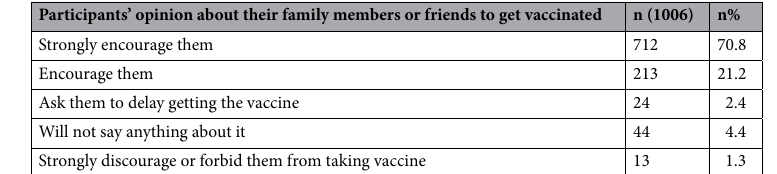
Table 3. Frequency distribution of the opinion of the participants about the willingness of their friends or family to be vaccinated.